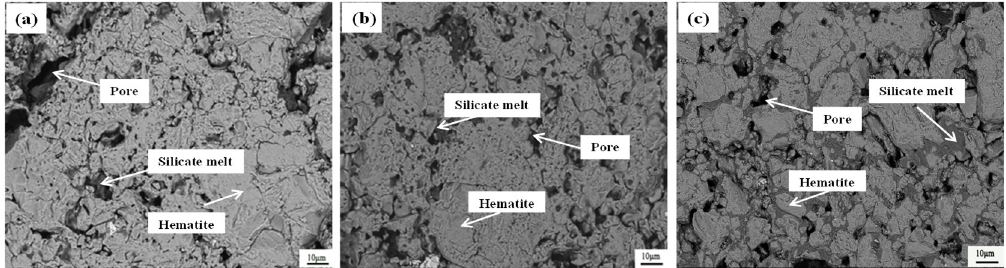
ff erent SiO 2 contents: ( a ) 2.19, ( b ) 4.63 and ( c ) 8.13